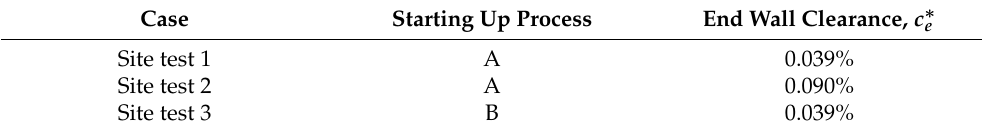
Table 3. The main settings for the site tests.